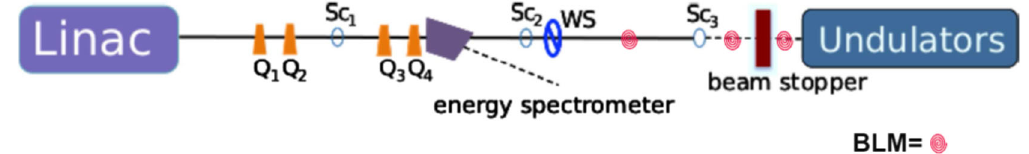
FIG. 13. Schematic layout of FERMI and of the SwissFELWSC and BLM setup. In the picture, the WSC is indicated as WS while the BLM are represented as a red spiral. Quadrupoles Q j ( j ¼ 1 ; … ; 4 ) and view-screens Sc i ( i ¼ 1 ; … ; 3 ) used at FERMI for emittance measurements are also sketched.